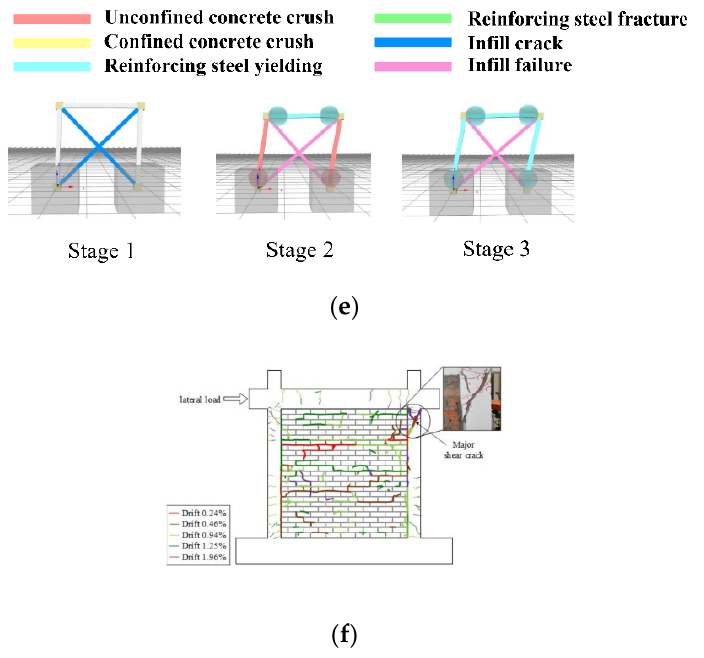
Figure 7. Comparison of analytical models in this study with experimental models [41]: ( a ) analytical and experimental results of the bare frame; ( b ) failure mechanisms of bare frame based on the analytical model; ( c ) failure mechanisms of the bare frame based on the experimental model; ( d ) analytical and experimental results of the infilled frame; ( e ) failure mechanisms of the infilled frame based on the analytical model; ( f ) failure mechanisms of the infilled frame based on the experimental model.